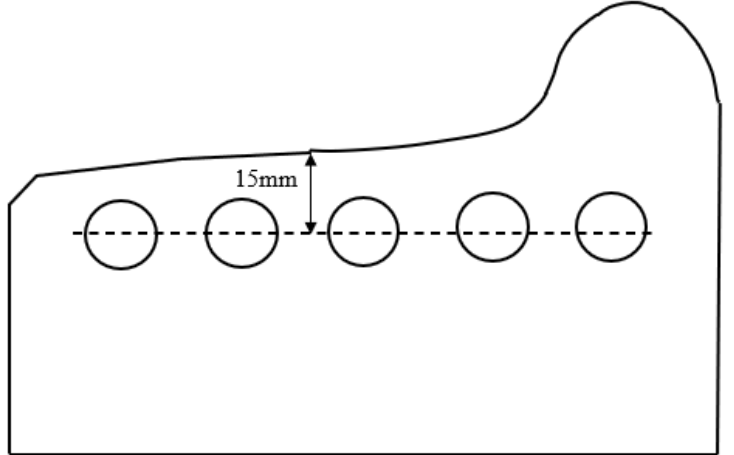
Figure 5. Schematic diagram of the specimen sampling location.